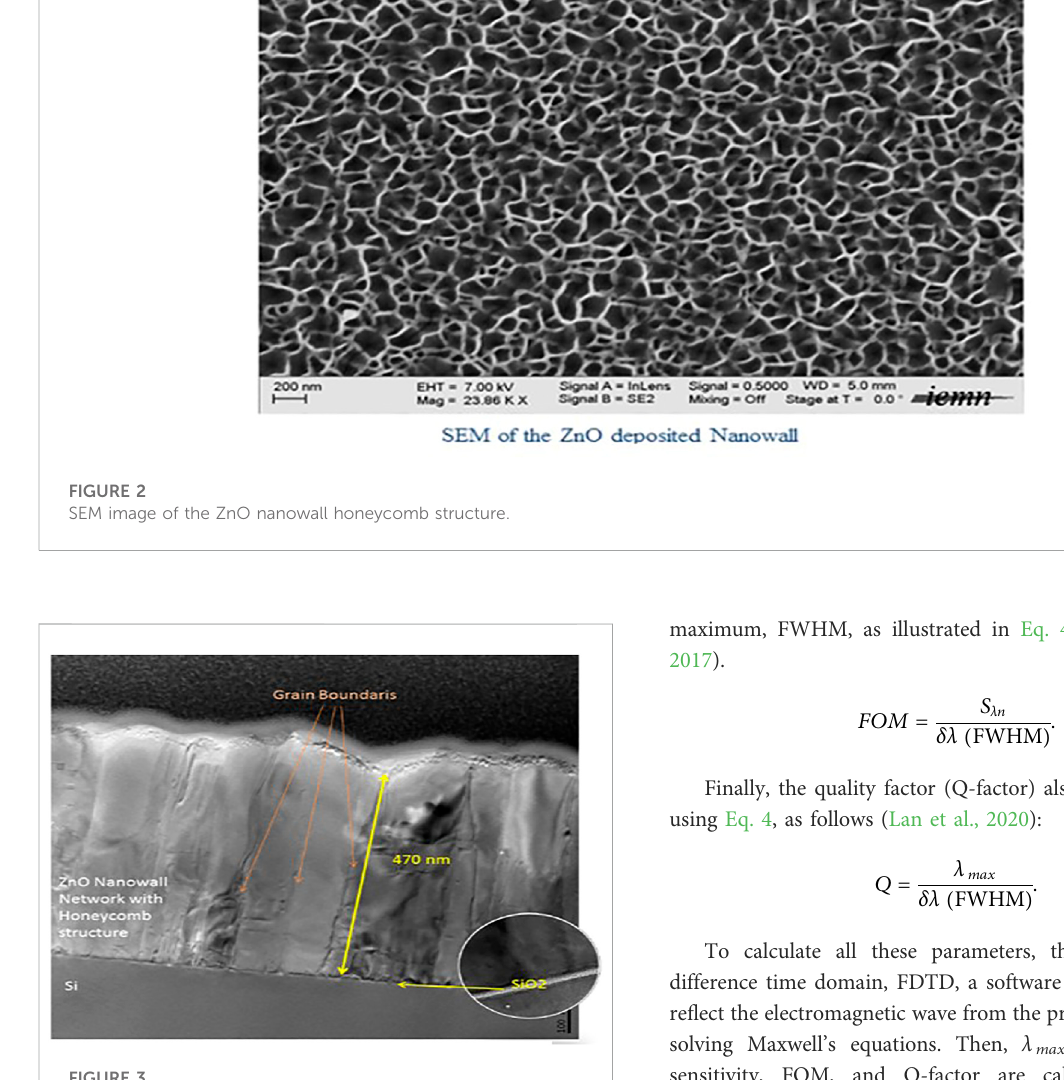
FIGURE 3 TEM images of ZnO NWaN with the honeycomb